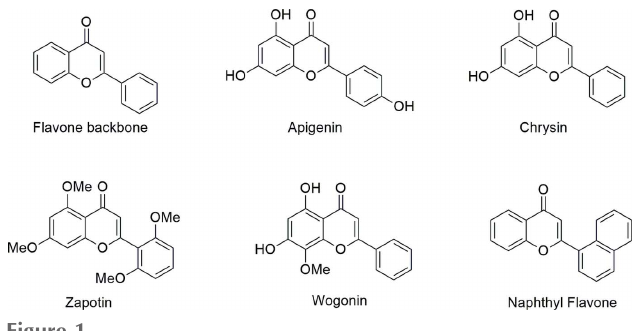
Figure 1 The flavone skeleton and some common naturally occurring flavones.